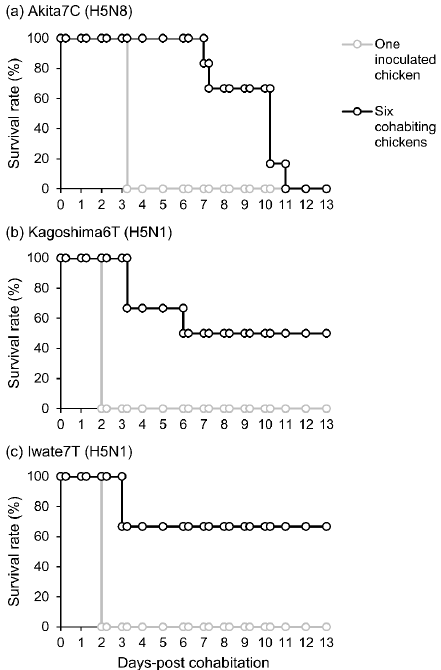
Figure 3. Survival rates of chickens intranasally inoculated with 10 6 EID 50 of ( a ) Akita7C, ( b ) Kagoshima6T, and ( c ) Iwate7T strains and cohabitated chickens. The survival rates of the virus ‐ inocu ‐ lated chicken and cohoused chickens are shown by black and white circles, respectively.